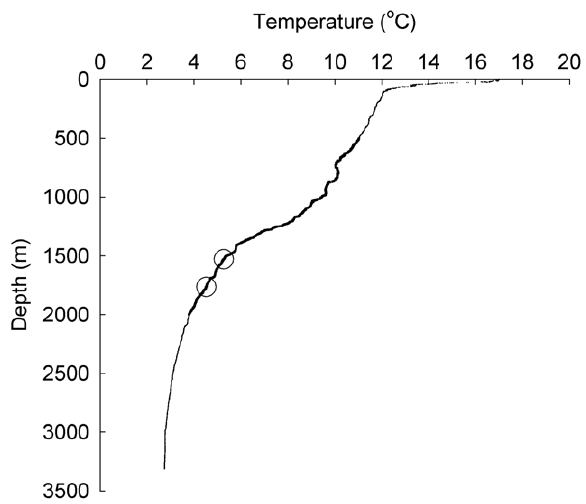
Figure 1. Temperature at depth in the Whittard submarine canyon, Gulf of Biscay. Temperature was sampled by ROV on 17 th July 2009. Temperatures within the known bathymetric range of the lysianassoid amphipod Stephonyx biscayensis are indicated by a heavier line. Depths of amphipod trap deployments and the corresponding temperatures are indicated by open